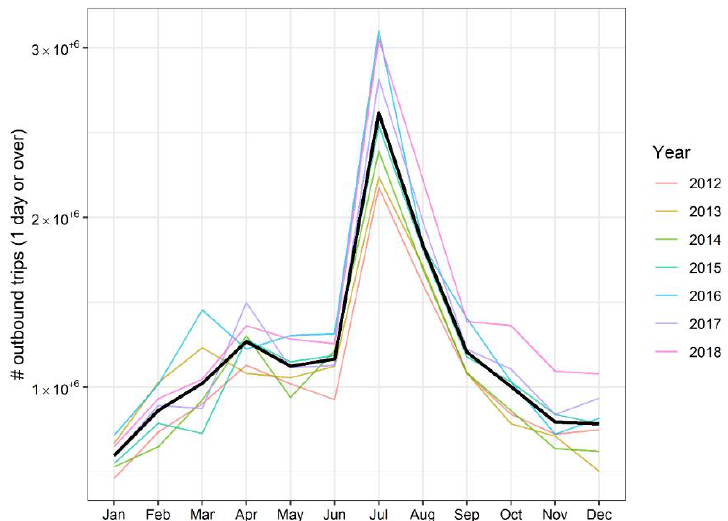
Figure 3. The number of outbound trips lasting at least 1 day made by residents of Belgium, by month. The black line represents the average trend of all years.